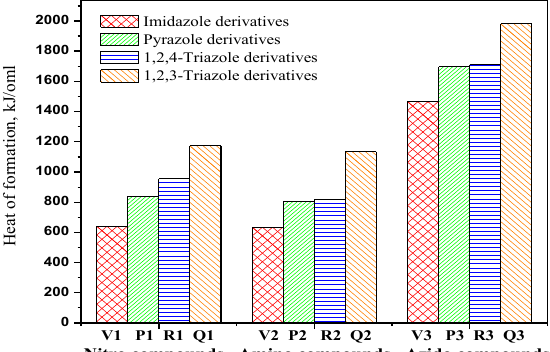
Figure 3. Heat of formation (kJ/mol) profile of the triazine